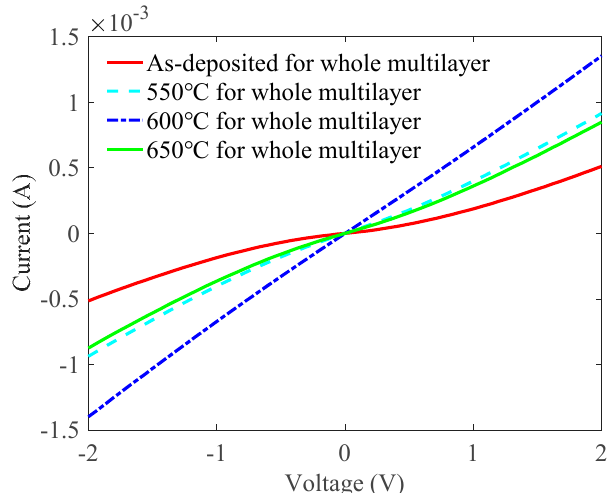
Figure 6. Effects of the annealing temperature of the whole ITO/Ga 2 O 3 /Ag/Ga 2 O 3 multilayer on I - V characteristic curves of the ITO/Ga 2 O 3 /Ag/Ga 2 O 3 multilayer when the thickness of the ITO contact layer was 12 nm, the annealing temperature of the ITO contact layer was 550 °C, and the thickness of the Ag metal layer was 17.5 nm.